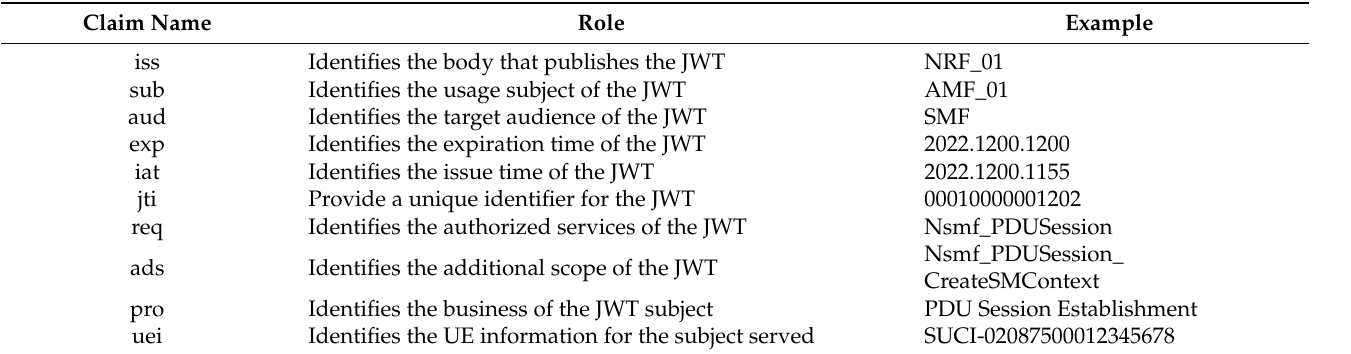
Table 5. The content declared in the